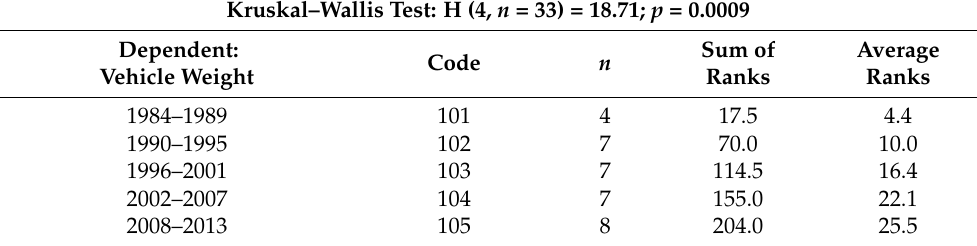
Table 3. Kruskal–Wallis test